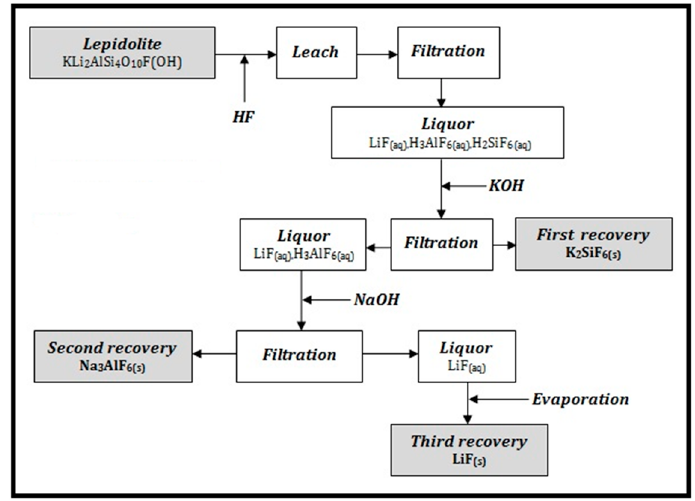
Figure 2. Generalized process flow sheet for Li, Si and Al recovery from lepidolite.